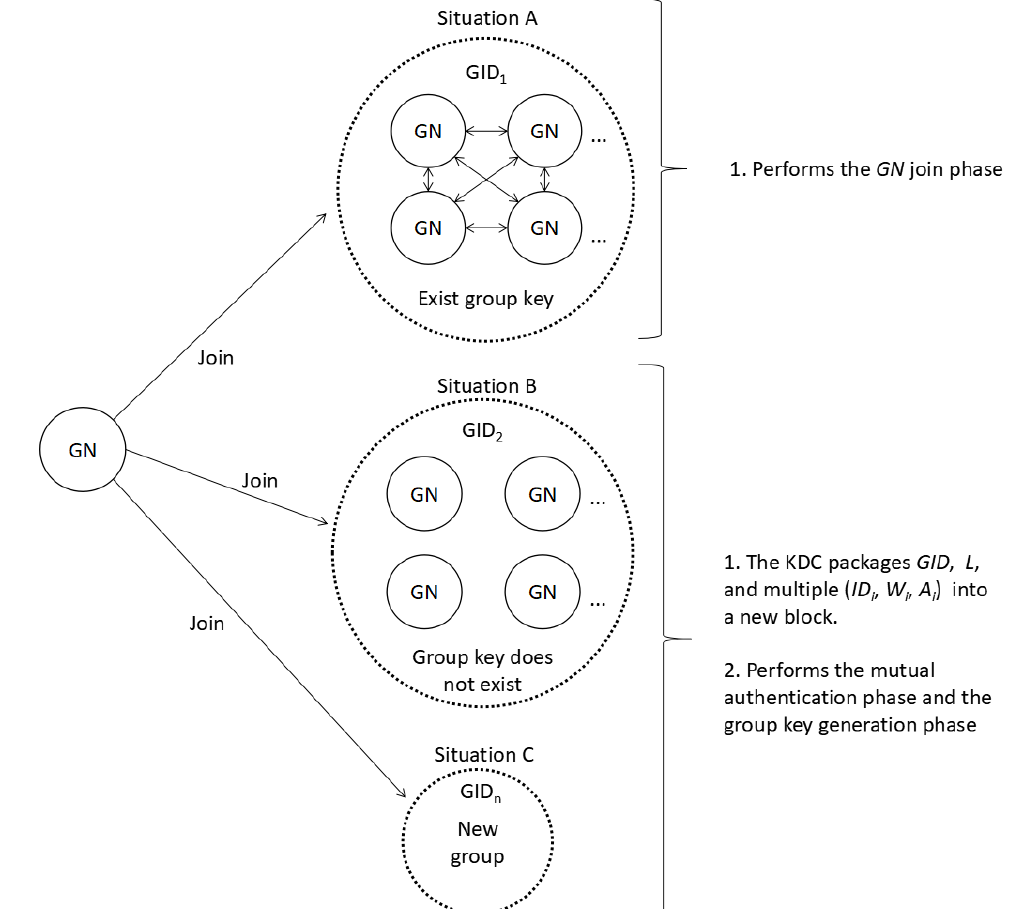
Figure 2. The three situations faced by the GN and the solution